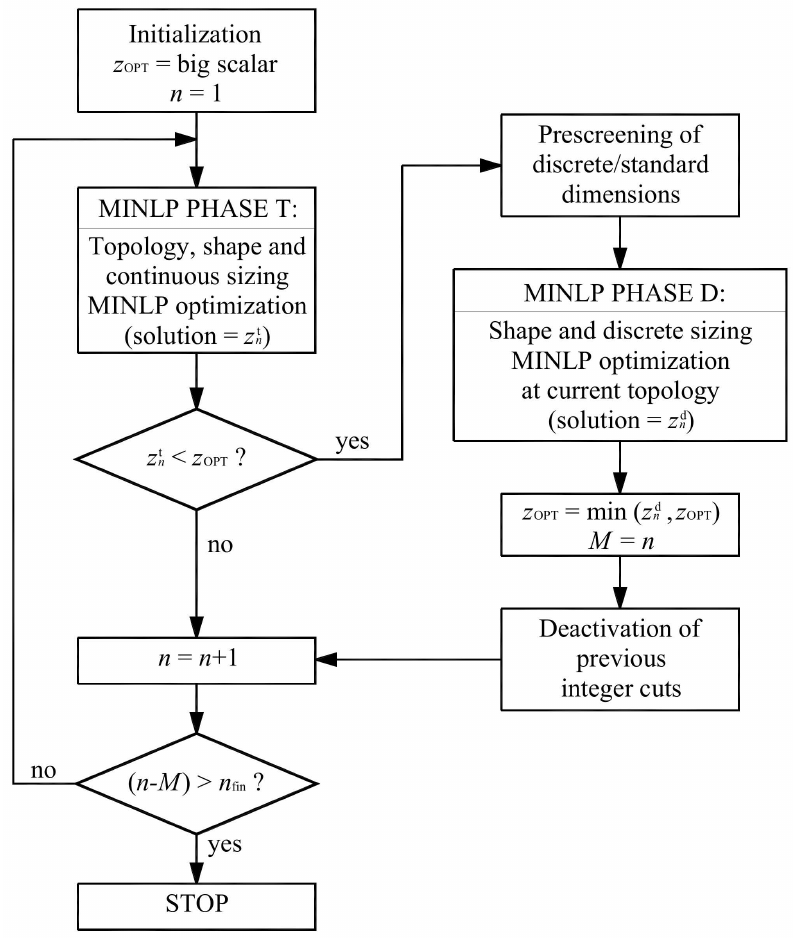
Figure 3. The Modified Two-Phase (MTP) MINLP